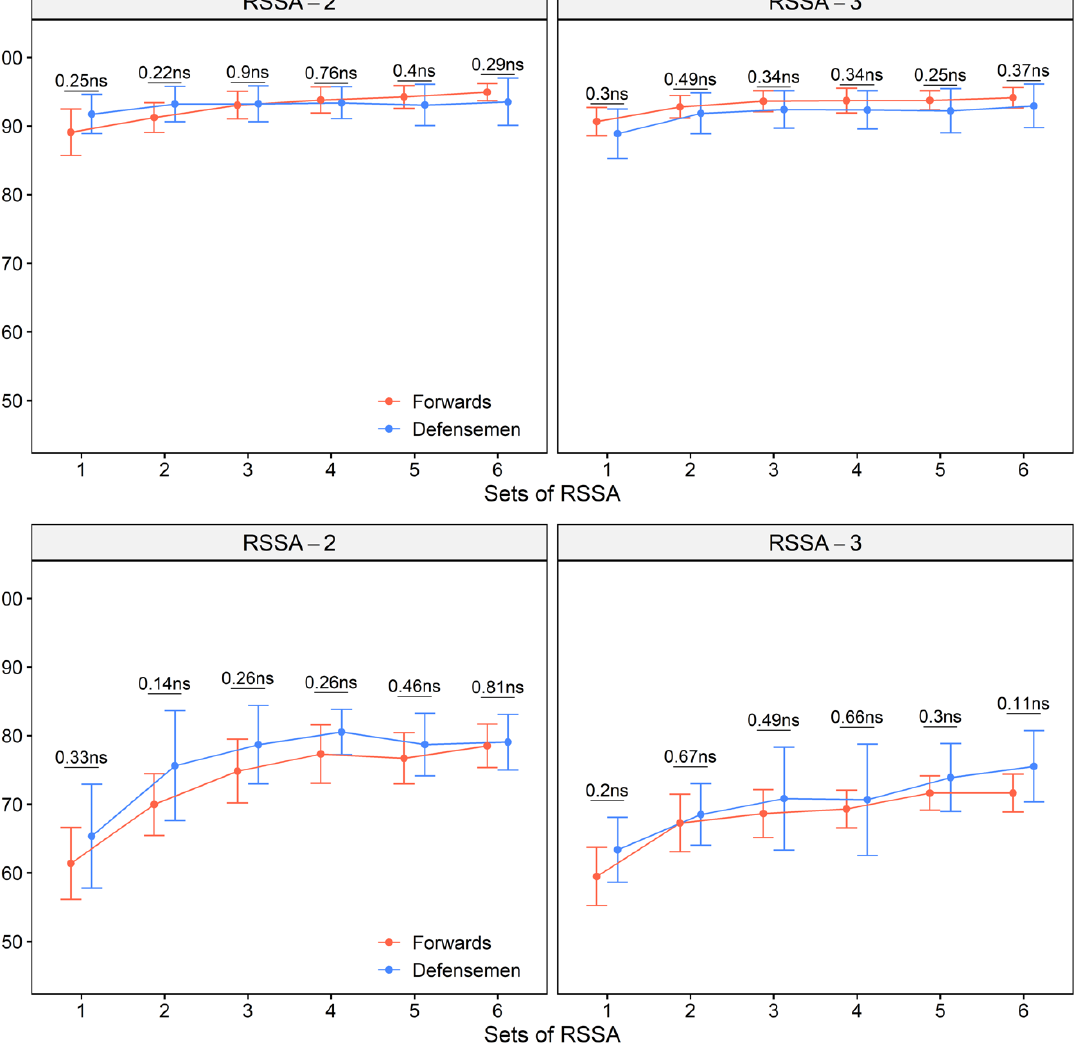
Figure 4. Peak HR and minimum HR of the forwards and defensemen during various sets of RSSA-2 (above) and RSSA-3 (below) tests (ns—non-significant).